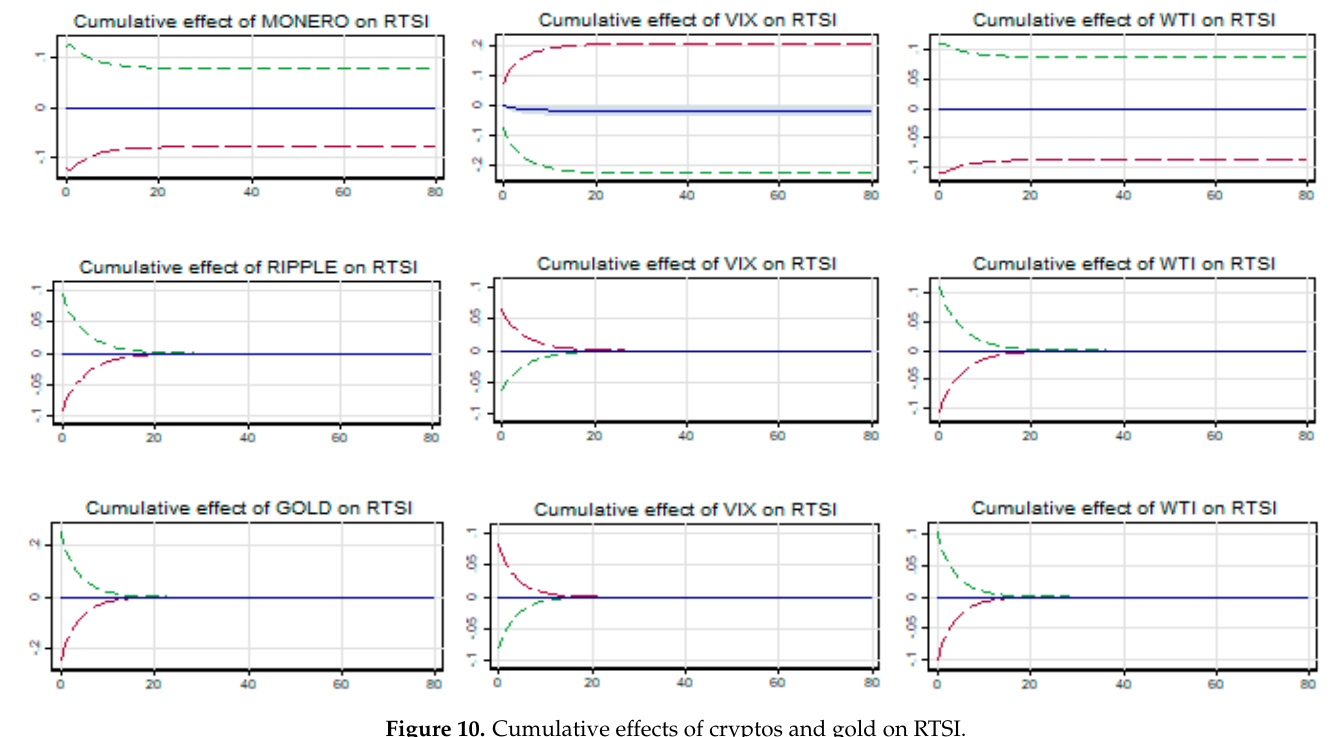
Figure 10. Cumulative effects of cryptos and gold on RTSI.